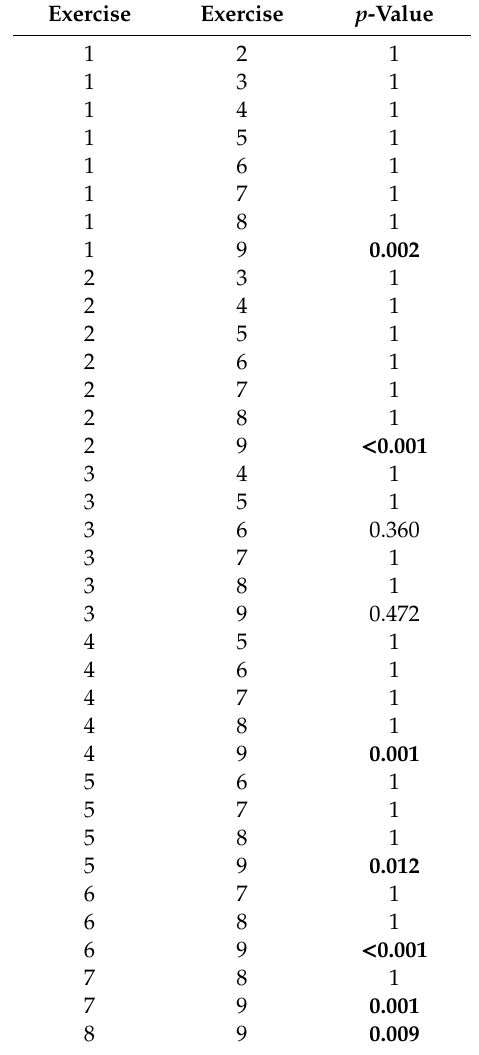
Figure 3. The tolerability of each exercise. Table 2. p -values of post-hoc comparison between tolerability of each exercise performed.